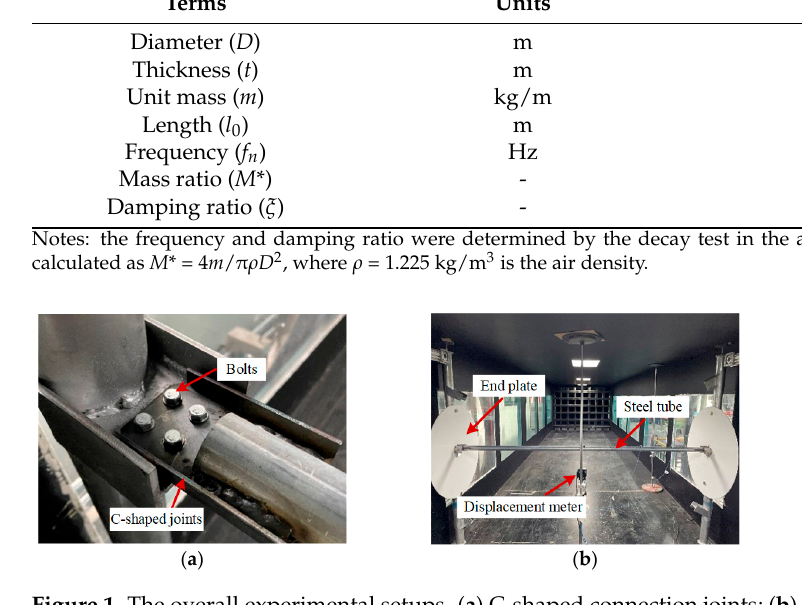
Table 1. Main physical parameters of the test tubes.